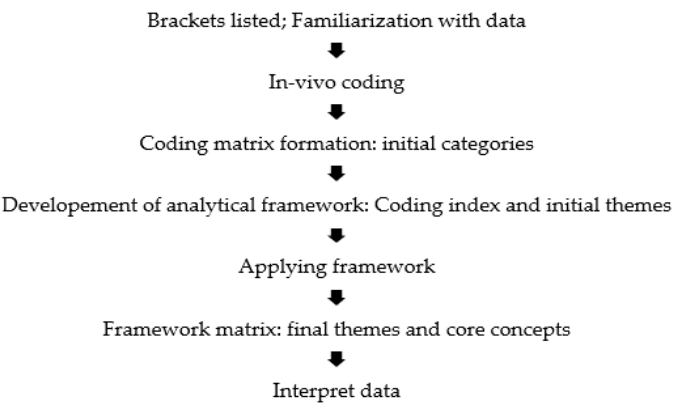
Figure 1. Illustration of modified Framework Method utilised.